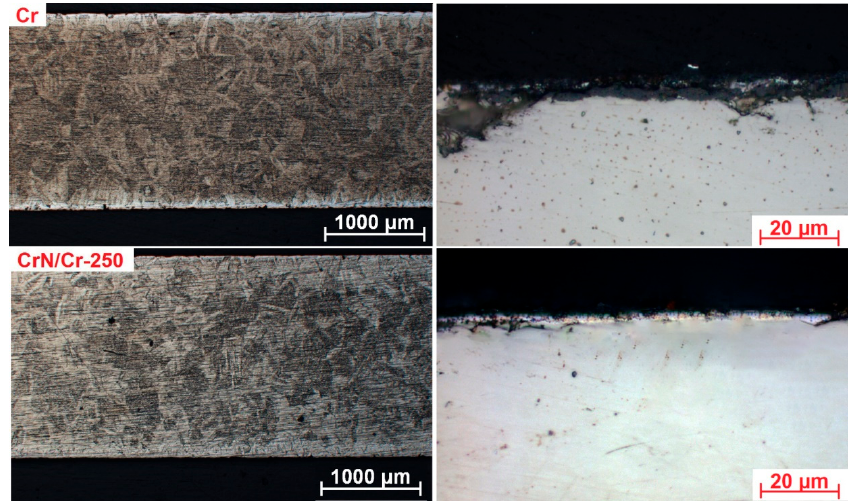
Figure 5. The cross-section microstructures of the Cr and CrN/Cr-250 samples after 20 min oxidation. Despite a small difference in weight gains after 20 min oxidation, the microstructures of the Cr and CrN/Cr-250 samples near the surface are different. The Cr sample has a less uniform, thinner and discontinuous layer of residual chromium, while the continuous Cr layer (~1 µm) is found for the CrN/Cr-250